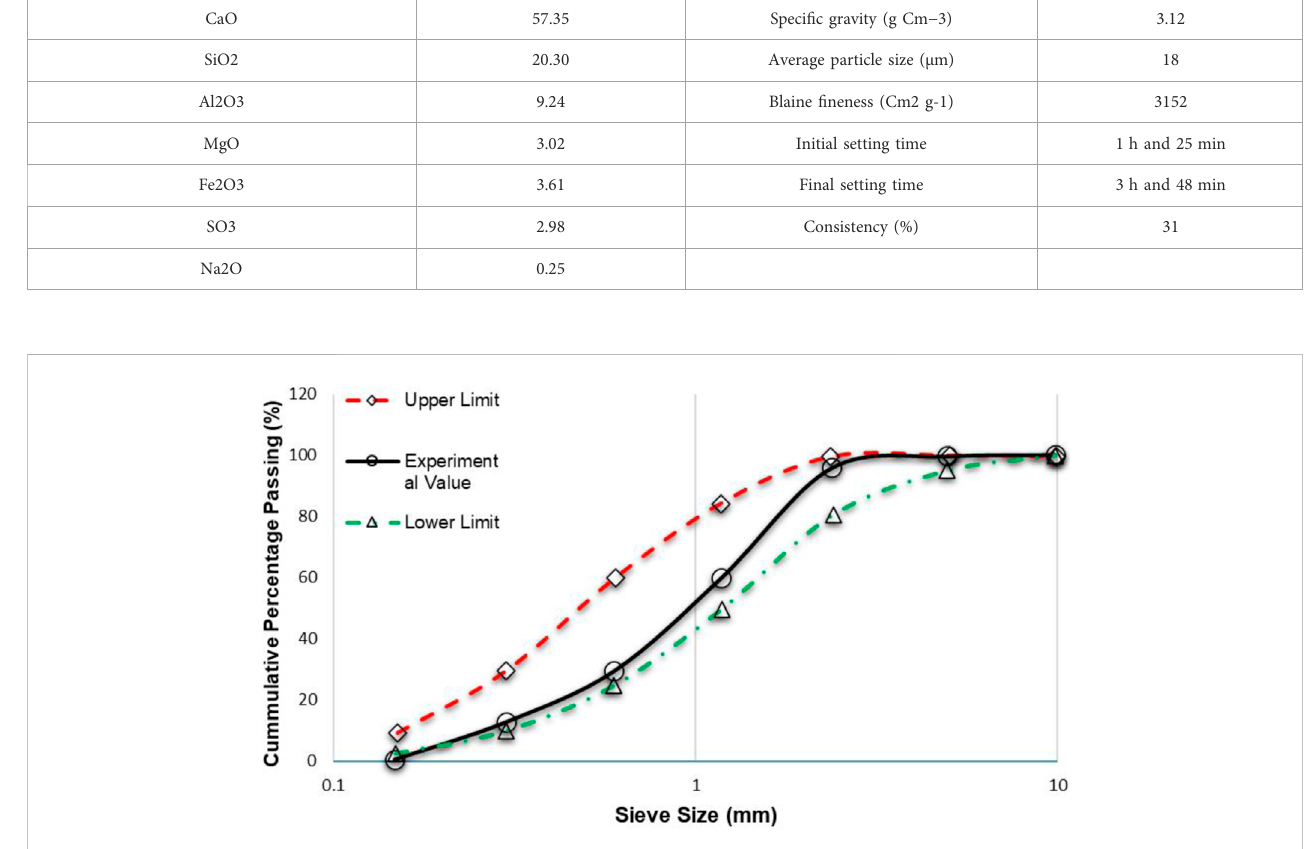
TABLE 1 Physical and chemical properties of cement. Chemical composition